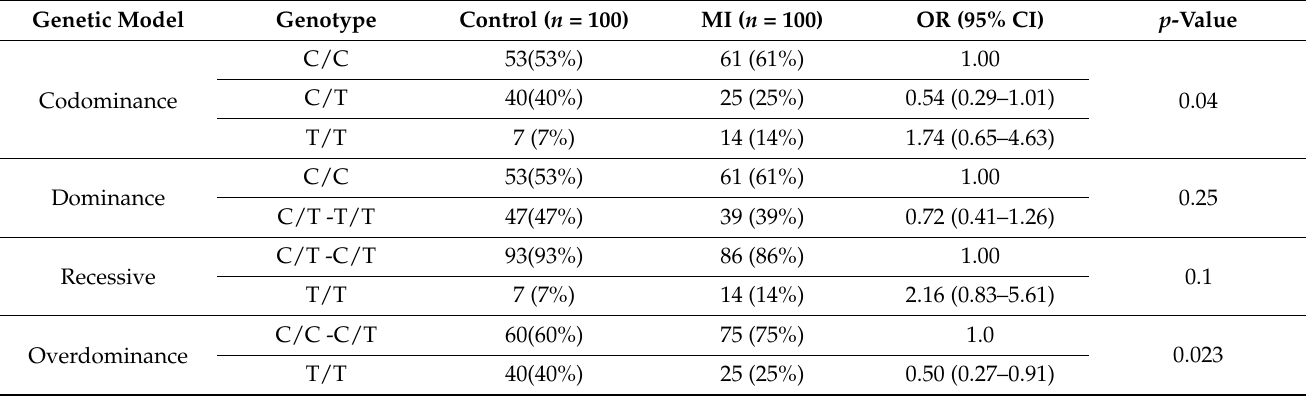
Table 5. Association of MTHFR C677T (rs1801133) single nucleotide polymorphism in the control and myocardial infarction (MI) study groups ( n = 200).